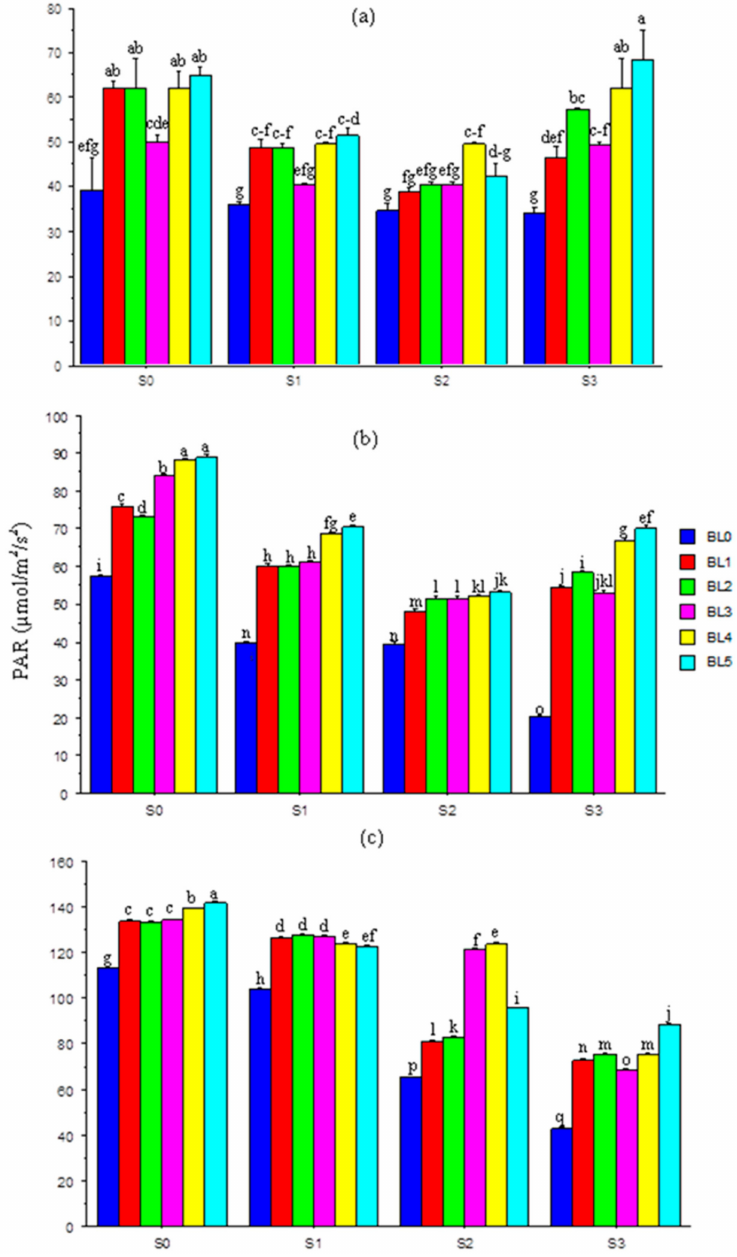
Figure 1. Interaction effects of salinity × brassinolide on PAR of soybean at 20 ( a ), 30 ( b ) and 40 ( c ) DAS. PAR—photosynthetically active radiation; BL—brassinolide; S—salinity; DAS—days after sowing; BL0—no BL application (control); BL1—BL application at seedling; BL2—BL application at flowering; BL3—BL application at podding; BL4—BL application at seedling + flowering; BL5—BL application at seedling + flowering + podding; S0—1.10 mM/L (control); S1—32.40 mM/L; S2— 60.60 mM/L; S3—86.30 mM/L. Mean pairs with different letters are significantly different at the 5% probability level according to Duncan’s new multiple-range